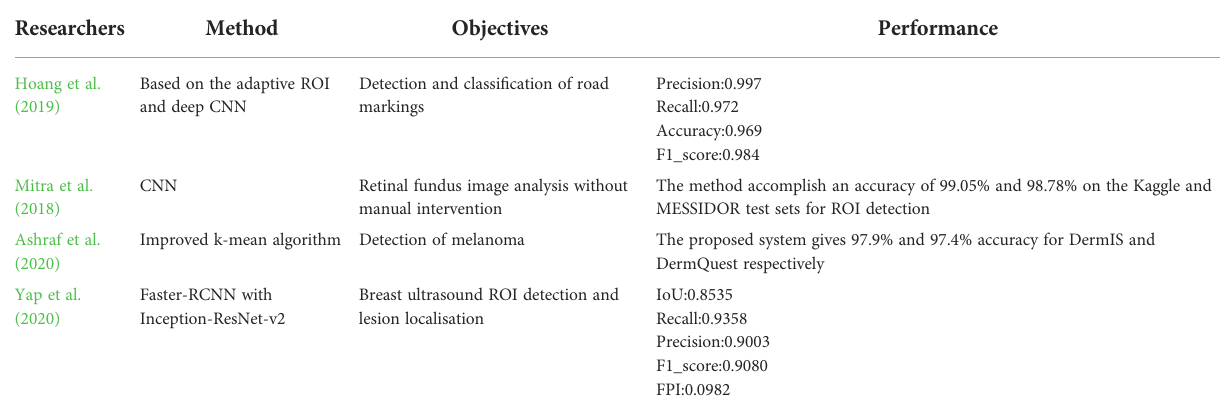
TABLE 1 The related works of